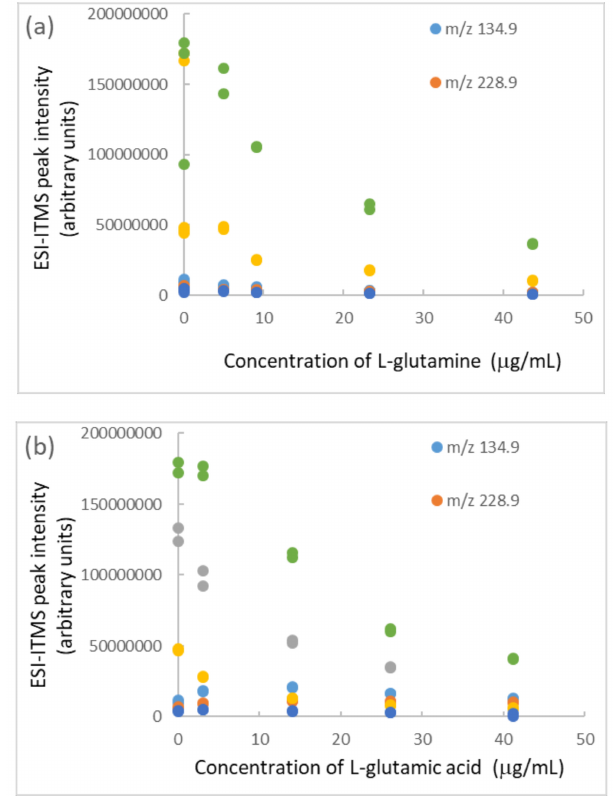
Figure 5. Impact of ( a ) l -glutamine and ( b ) l -glutamic acid on the ESI-ITMS analysis of BPA solution